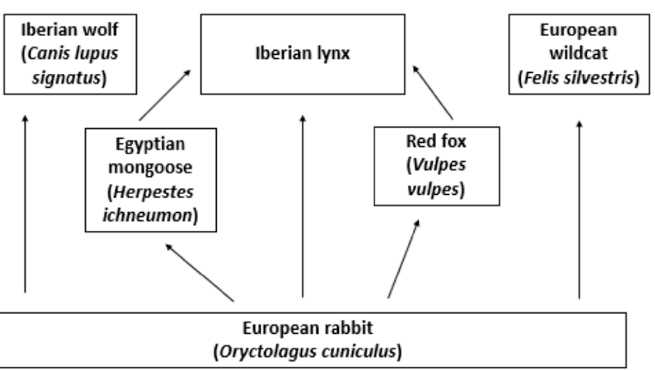
Figure 1. Simplified (and partial) overview of the Iberian lynx food web (based on [33,34]).